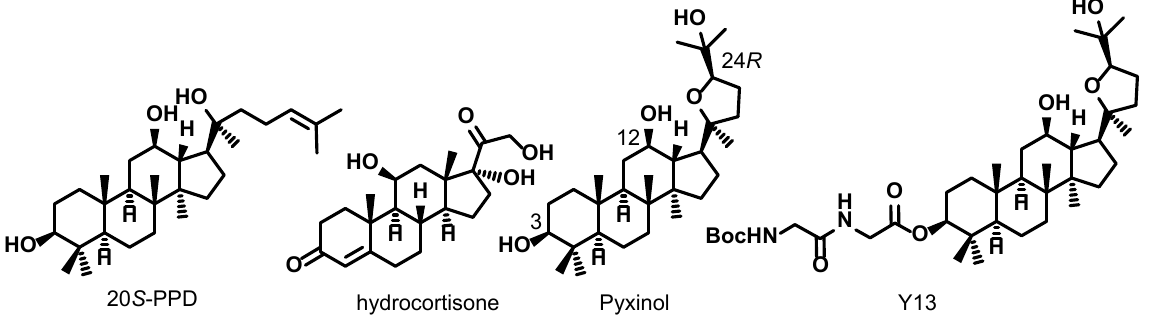
Figure 1. Chemical structures of 20 S -PPD, hydrocortisone, pyxinol, and Y13.